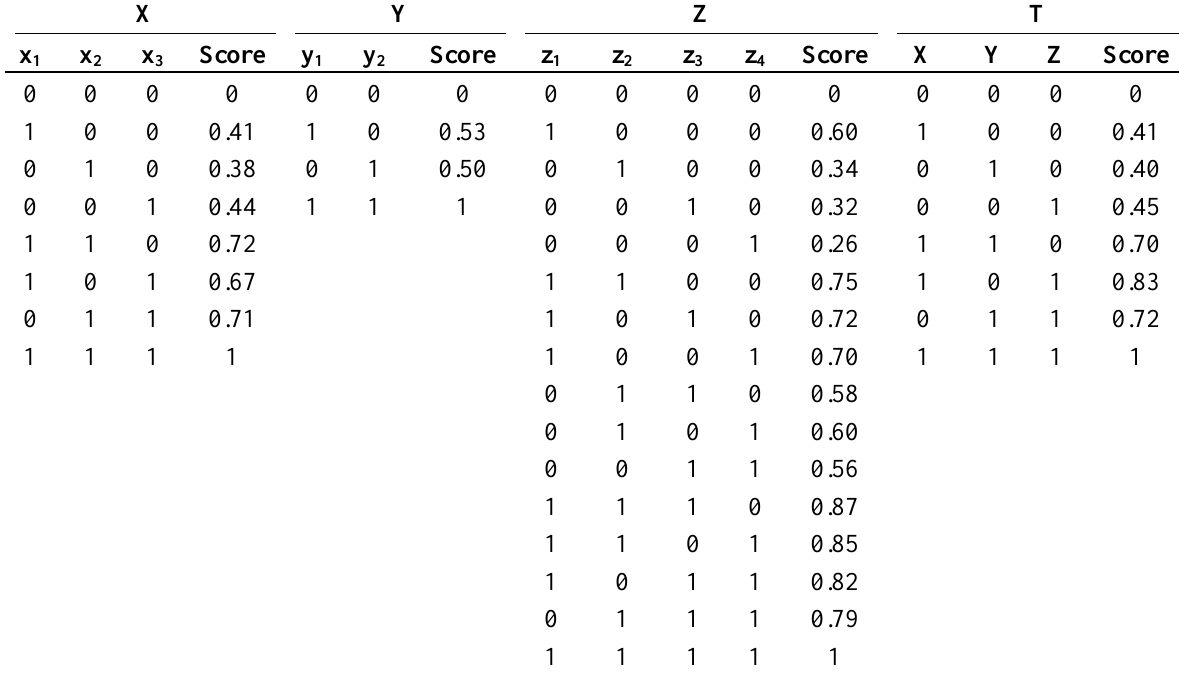
Table 4. Fuzzy measure scores of various indicators coalitions for the